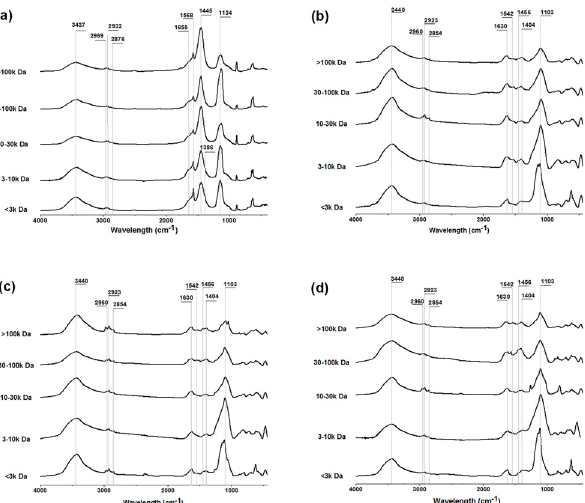
Fig 5. FTIR spectra of raw waters and freeze-dried flocs by coagulation in different MW fractions. (a) raw waters; (b) AlCl 3 , pH 5.0; (c) PACl, pH 5.0; (d) PACl, pH 6.0. Coagulants dose: 0.8 mg Al/mg DOC.